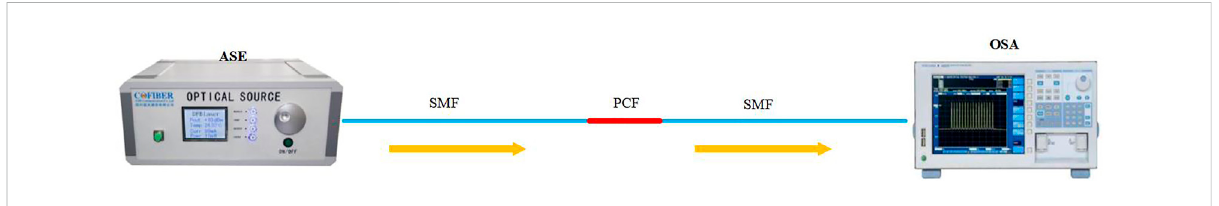
FIGURE 1 Single-mode fi ber — PCF- Single-mode fi ber structure